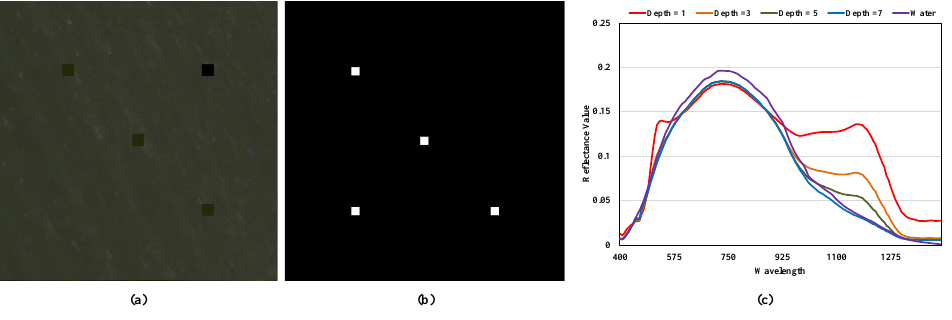
Figure 9. Synthetic data based on river water for experiment. ( a ) Image scene of river water; ( b ) distri- bution of desired targets; and ( c ) spectra of desired targets and main